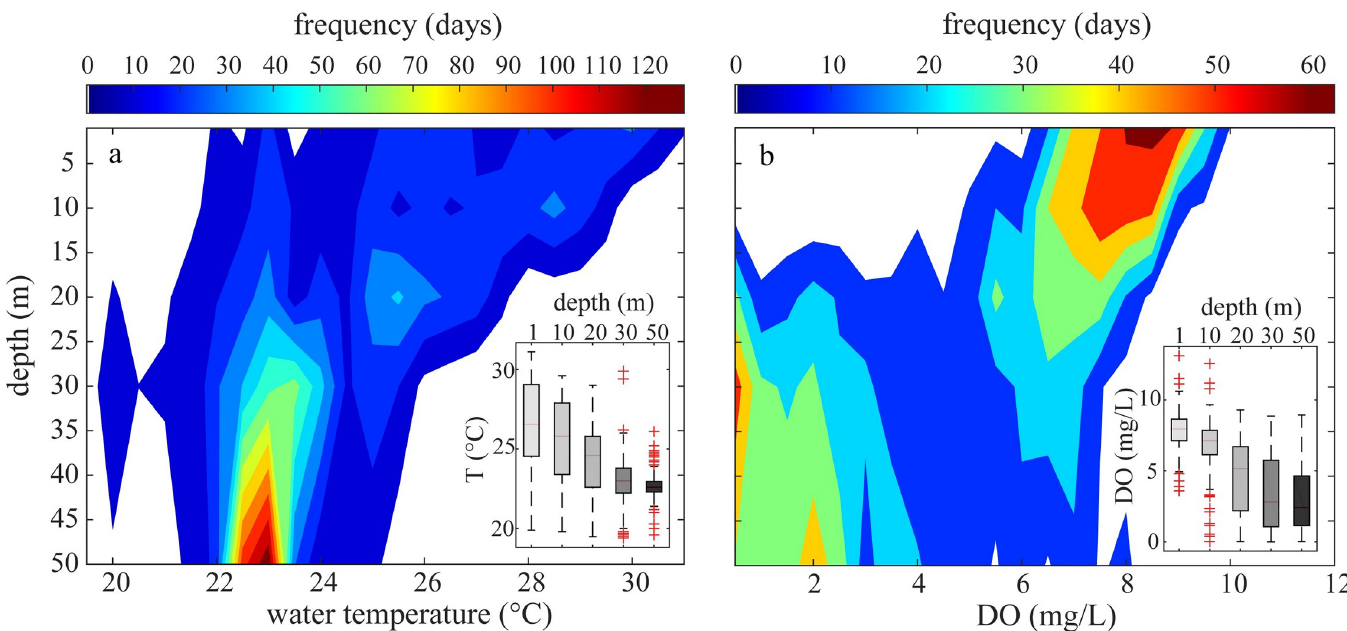
Fig 7. Frequency maps of lake water temperature and dissolved oxygen. Empirical frequency maps of (a) water temperature-depth and (b) oxygen as a function of water depth for Lake Kariba calculated by using the aggregated database of this study [34]. Frequency is quantified as the average number of days per year (colour-coded) in which observed temperatures and oxygen concentrations fall within a bin of 0.5˚C for temperature and 0.5 mg L -1 for oxygen. The box plots show the statistical distributions (medians, 25 th and 75 th percentiles) of water temperature and dissolved oxygen at five different depths. The whiskers extend to the most extreme data points not considered outliers, and the outliers are plotted individually using the ’+’